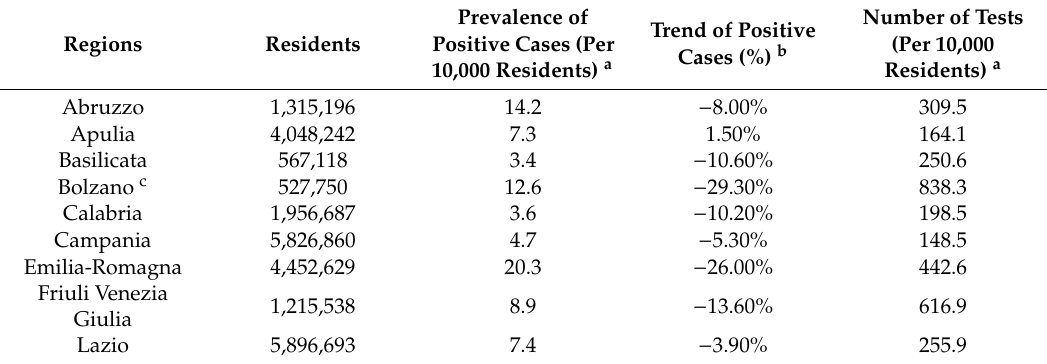
Table 1. Characteristics of the Italian